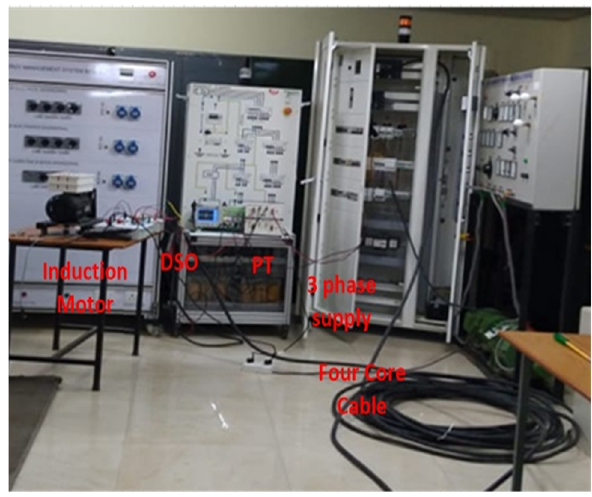
Figure 4: Experimental setup consisting of motor load and